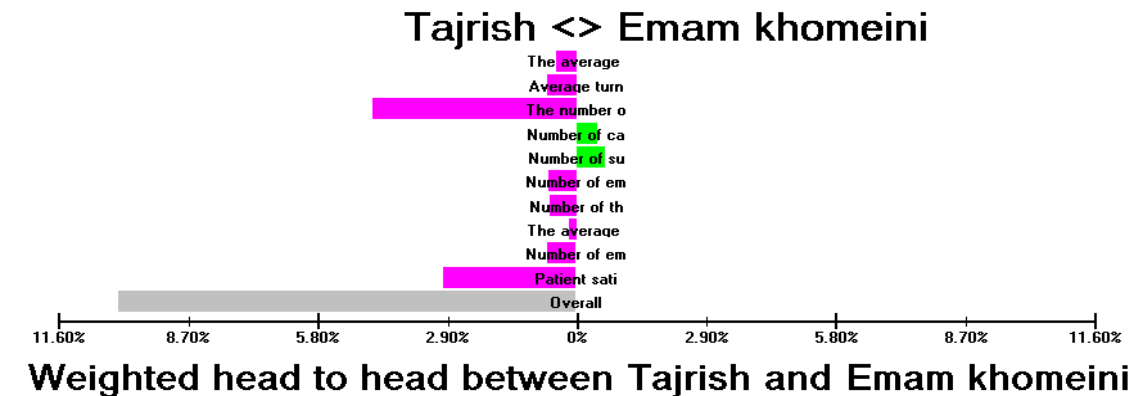
Figure 16. Head-to-head sensitivity’ graph for Tajrish and Emam Khomeini